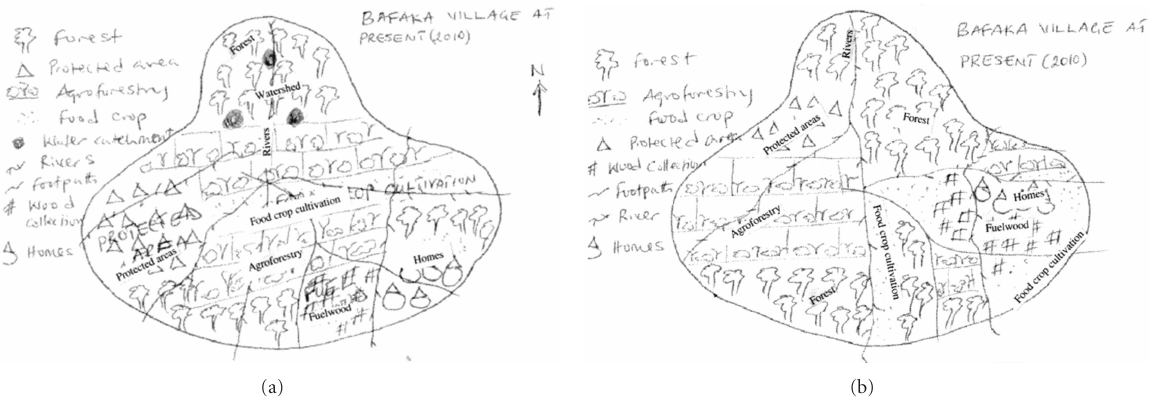
Figure 3: (a) Participatory resource map of the present landscape drawn by men of Bafaka showing the arrangement of the various resources in the area. (b) Participatory resource map of the present landscape drawn by women of Bafaka showing the arrangement of the various resources in the